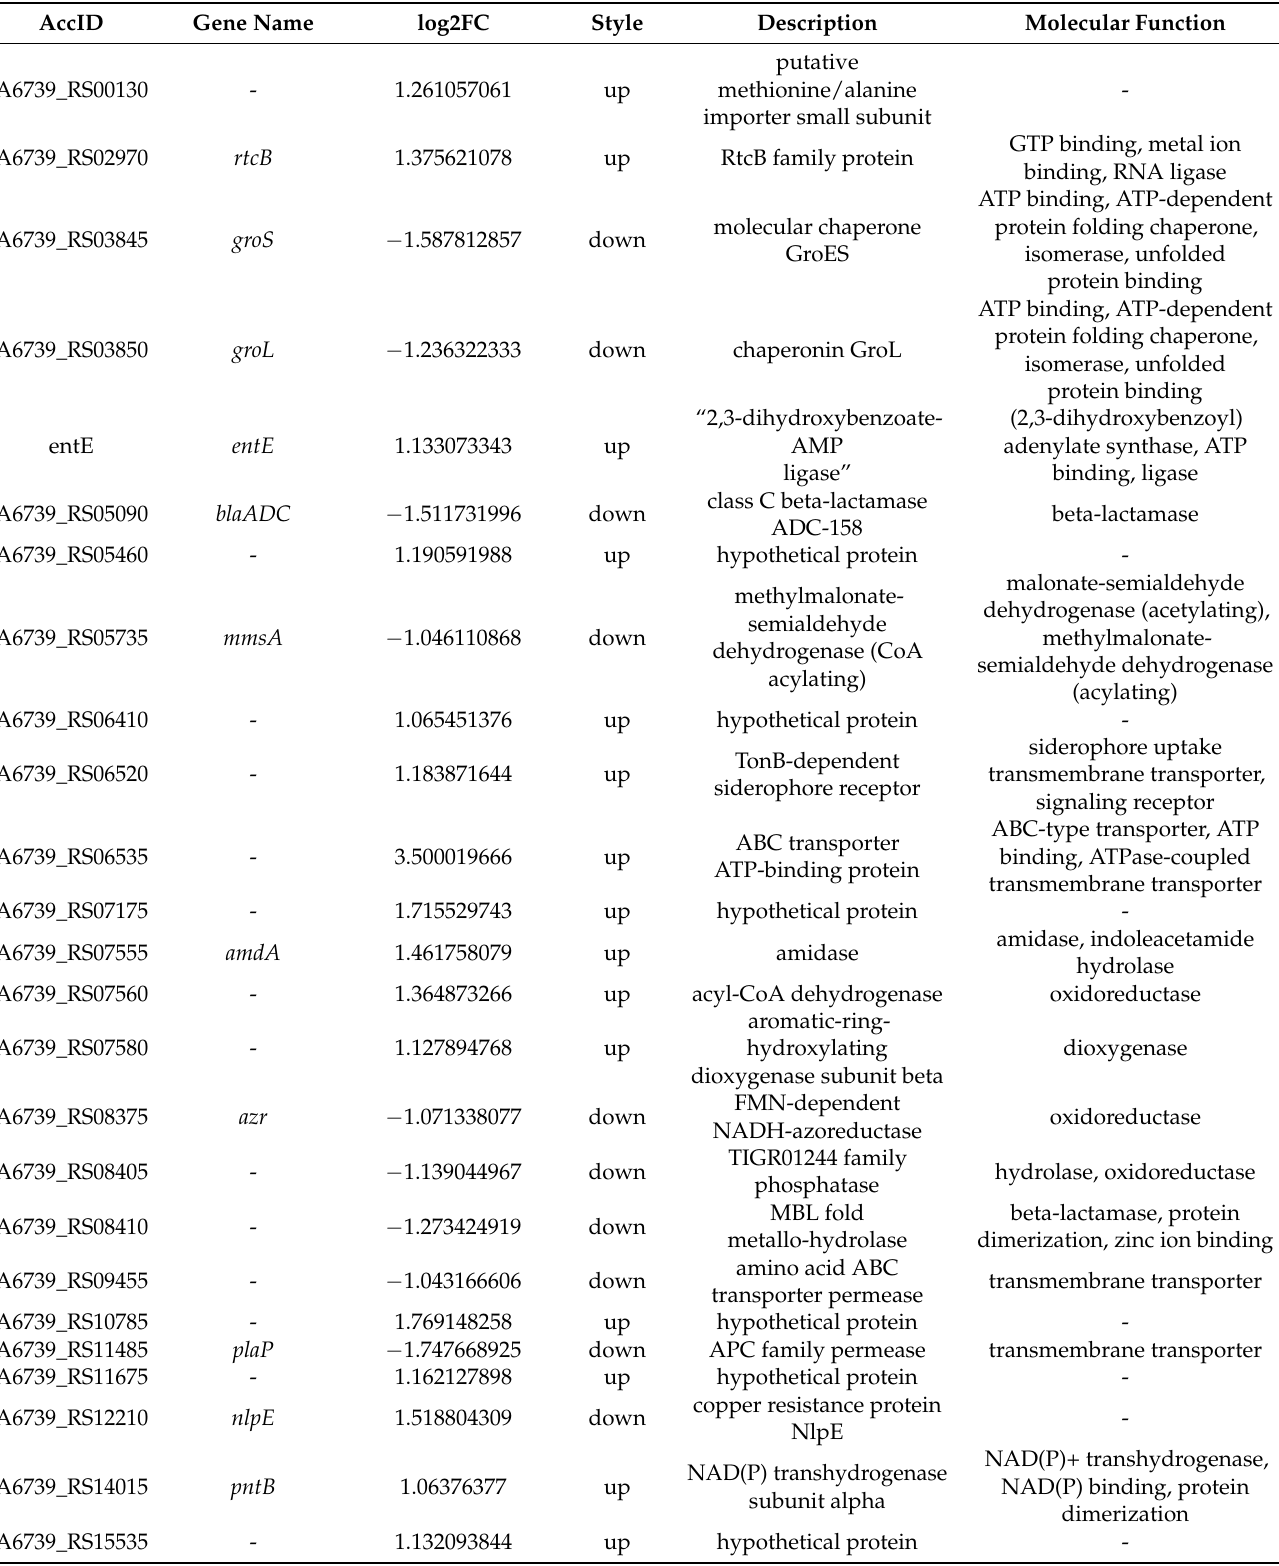
Table 1. Differentially expressed genes in the presence of